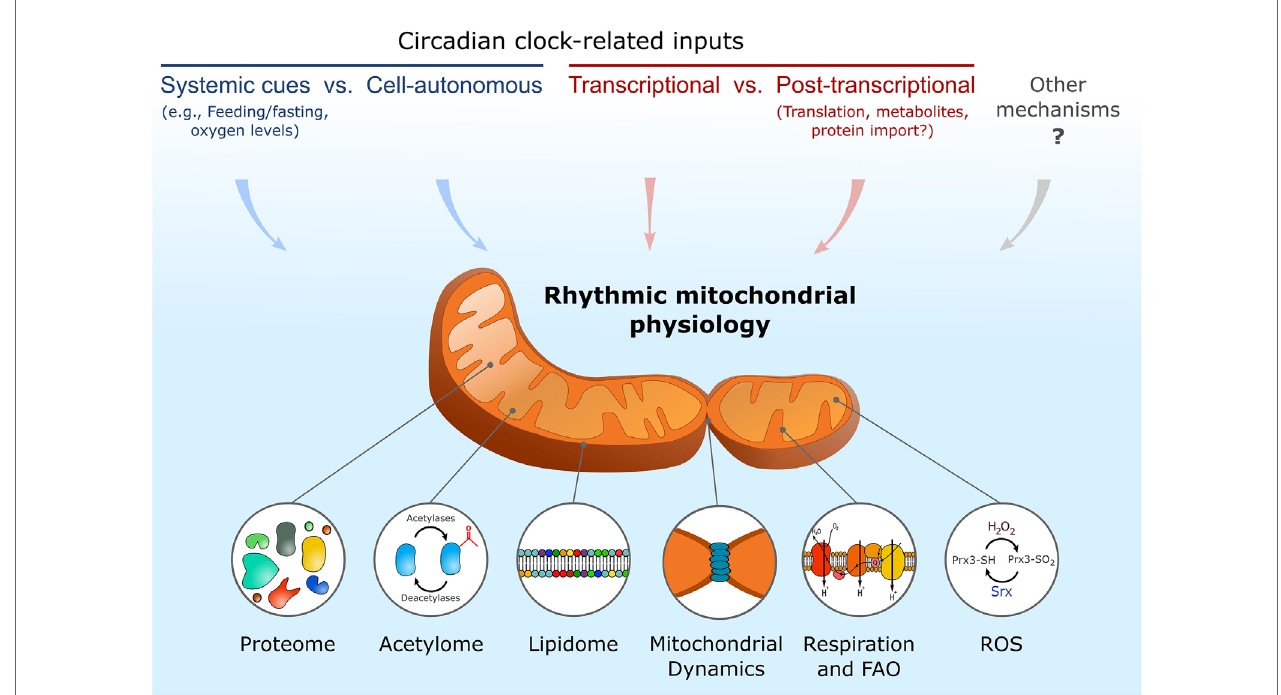
FiGURe 1 | Schematic depiction of key input mechanisms that participate in regulation of various circadian mitochondrial outputs . ROS, reactive oxygen species; FAO, fatty acid